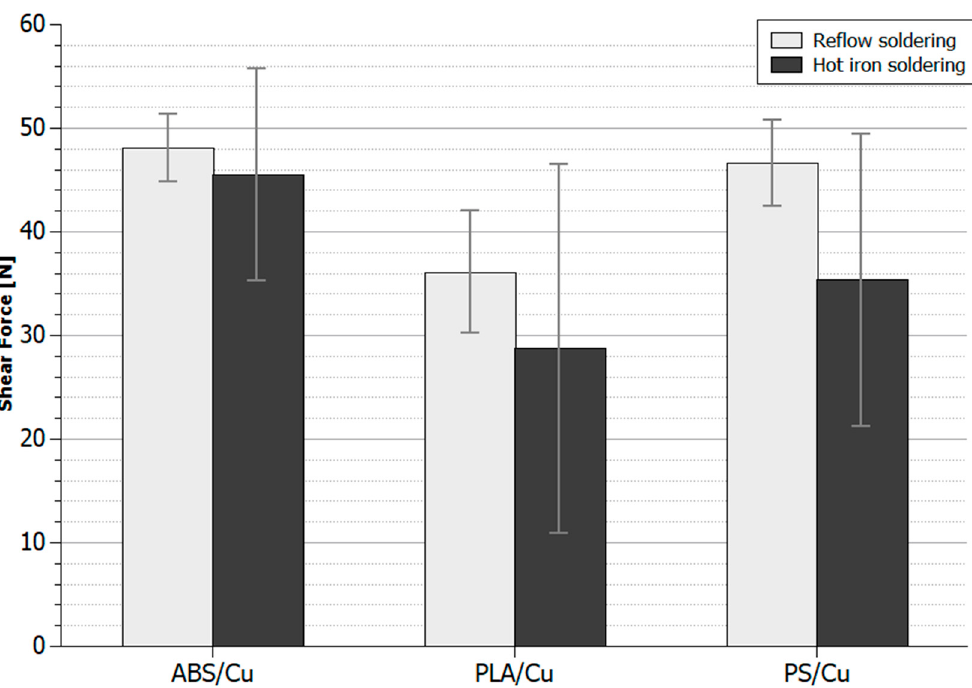
Figure 8. Shear force measurement results of soldering joints. All composite surfaces were mechanically cleaned with sandpaper and RF800 flux was applied before soldering.